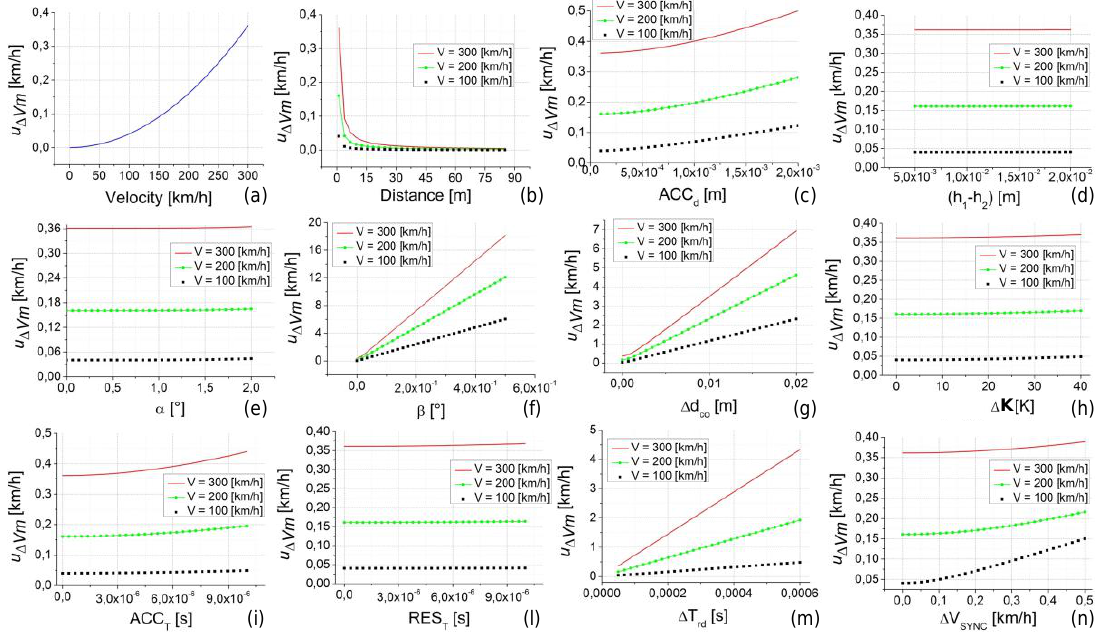
Figure 8. Uncertainty of the calibration method ( 𝑢 ∆𝑉 ) versus the uncertainty contribution parameters. 𝑚 In each plot from ( a – n ) the independent variable is one parameter. The plots are relative to the case study 1 (d = 1 m, speed = 100, 200, and 300 km / h, all the other parameters are set to their minimum value, as reported in Table